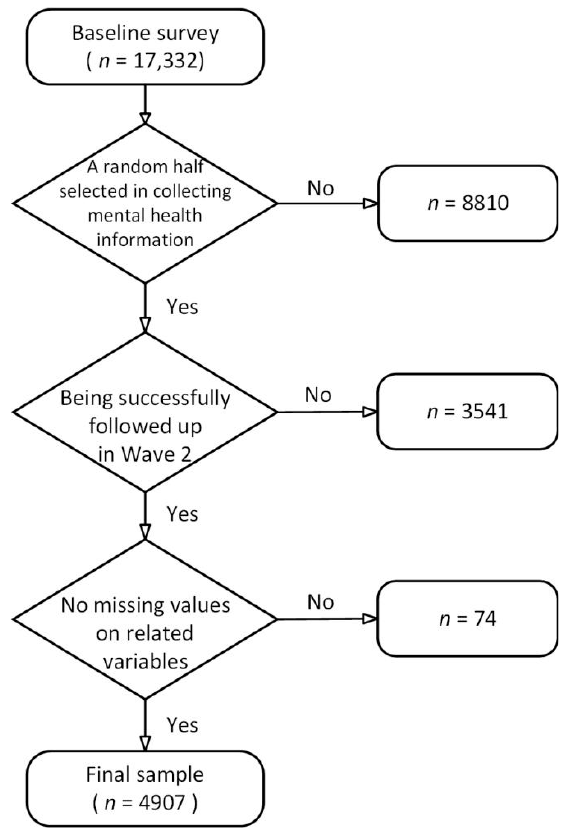
Figure 1. Flowchart for obtaining the final analytical sample.